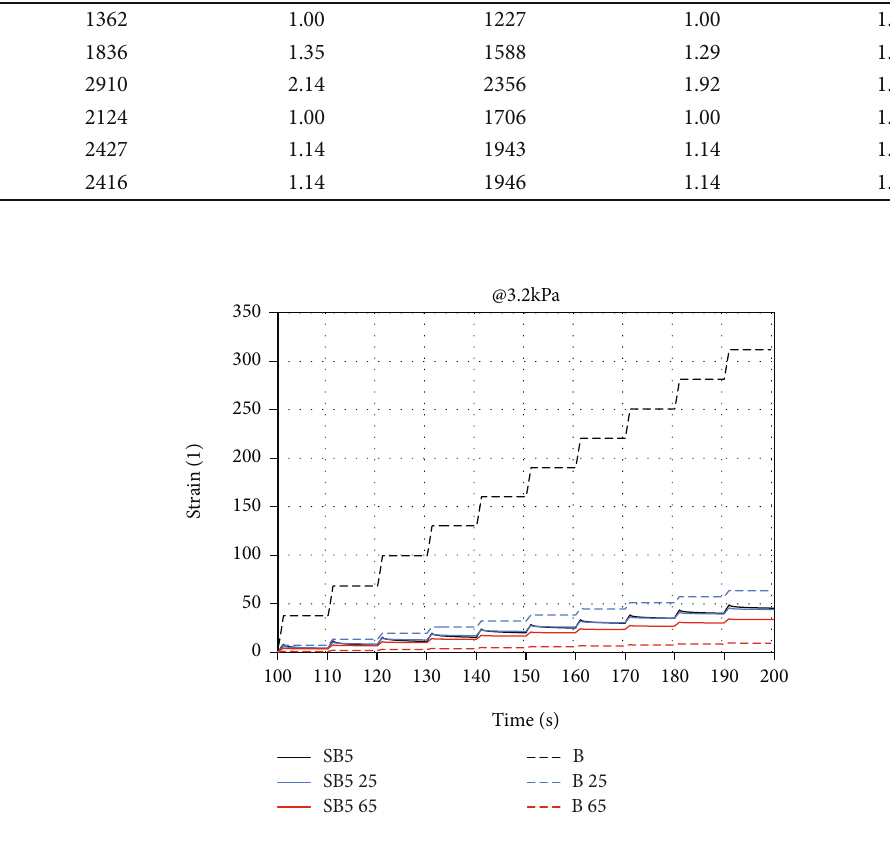
Table 2: Average apparent molecular weight, dispersion index, and corresponding aging indexes for B and SB5 at di ff erent levels of aging.